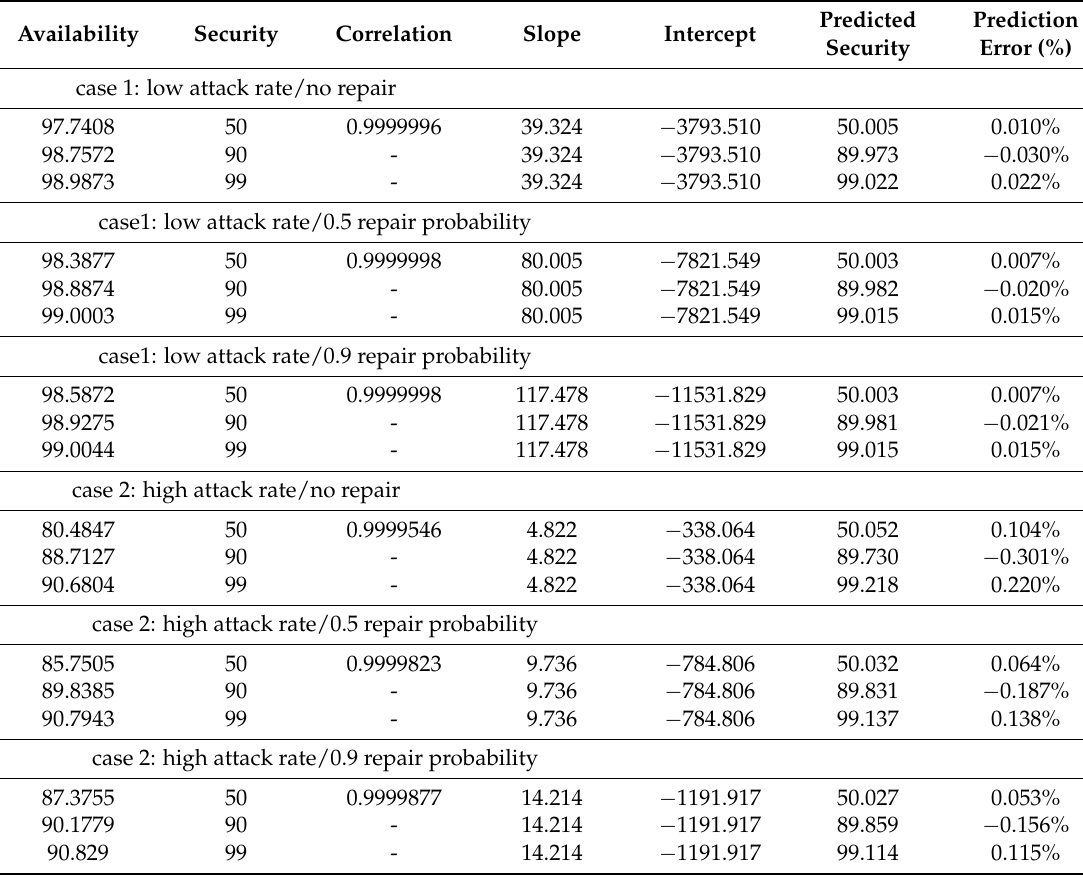
Table 2. Simulation